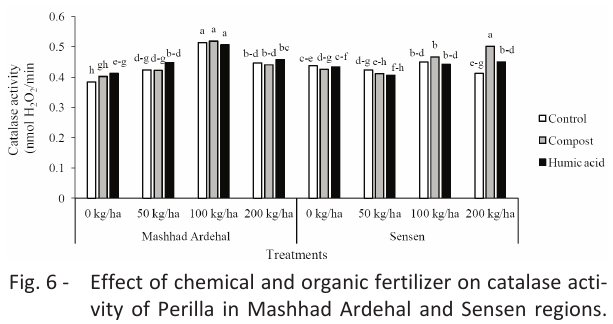
Fig. 6 - Effect of chemical and organic fertilizer on catalase acti- vity of Perilla in Mashhad Ardehal and Sensen regions. Different letters in each column denote a significant dif- ference at p≤0.05 (LSD test).